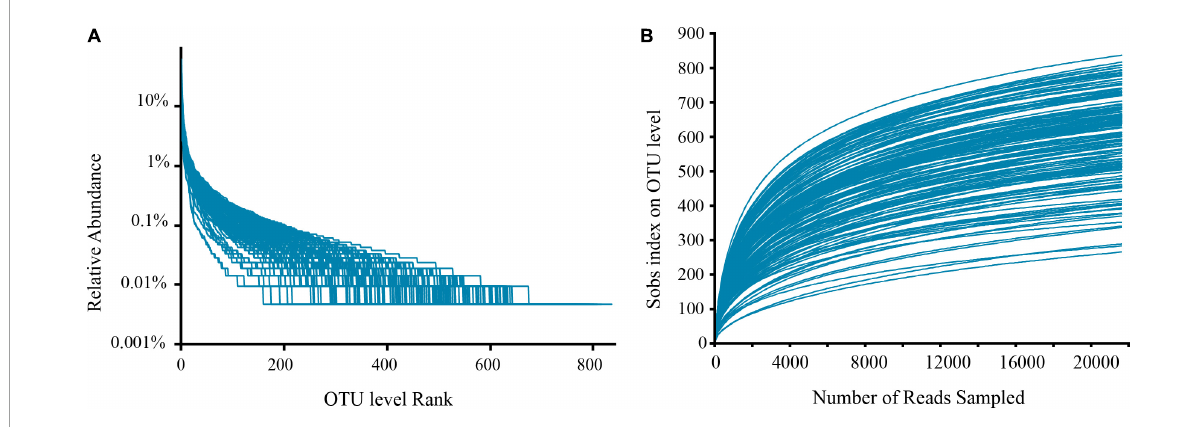
FIGURE1 Rank-abundance curves (A) and rarefaction curves (B) show sufficient sequencing